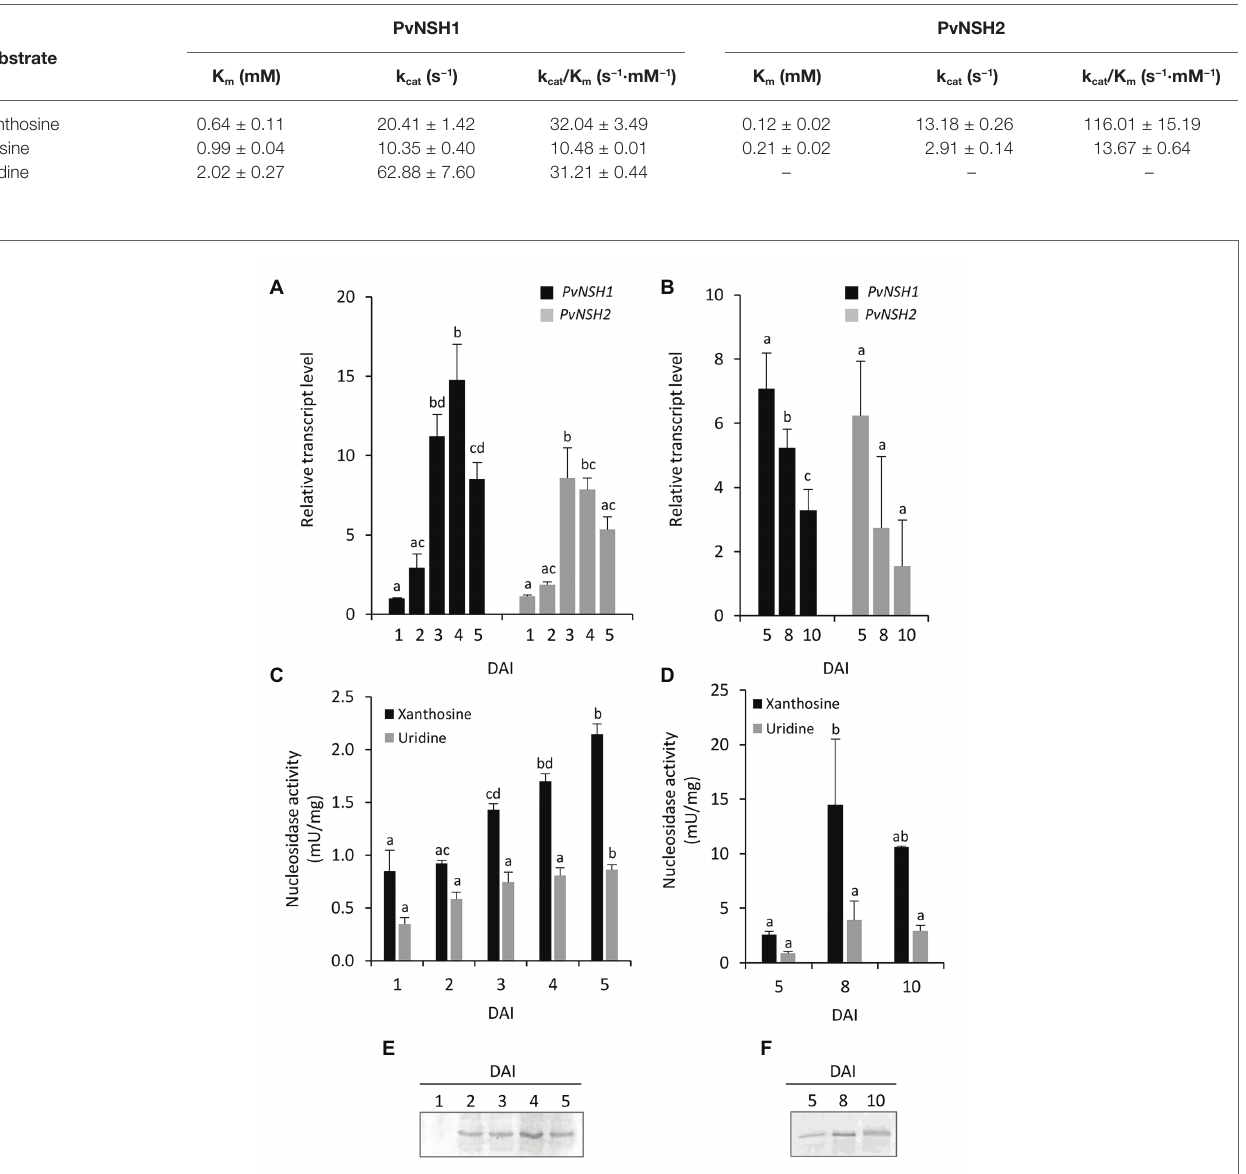
FIGURE 3 | Nucleosidase regulation during germinative and early postgerminative development of cotyledons. (A,B) Evolution of PvNSH1 and PvNSH2 mRNA levels, (C,D) nucleosidase activity, and (E,F) immunodetection of nucleosidase during germination and early postgerminative development. Real-time Quantitative Reverse Transcription PCR (qRT-PCR) results were normalized with the geometric mean of actin-2 and ubiquitin genes and expressed relative to the expression of PvNSH1 in cotyledons at 1 DAI, which was considered the value 1. Nucleosidase activity was assayed as described in the section “Materials and Methods”